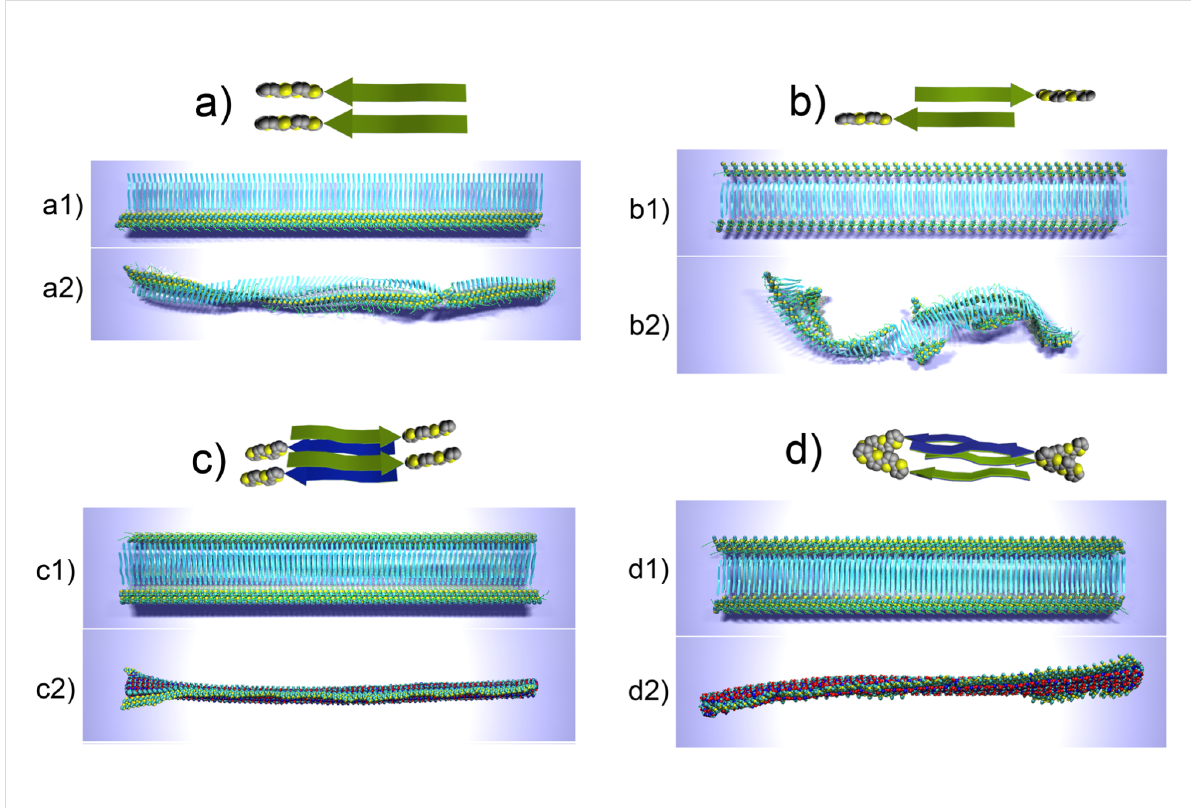
Figure 15: Snapshots of four different types of fibrils at the initial conformation (a1, b1, c1, d1) and after 10 ns of evolution (a2, b2, c2, d2). Peptide moieties are depicted with arrows, thiophene moiety using van der Waals spheres; images c2, c3, d2, d3 use van der Waals representation also for the peptide part for clarity